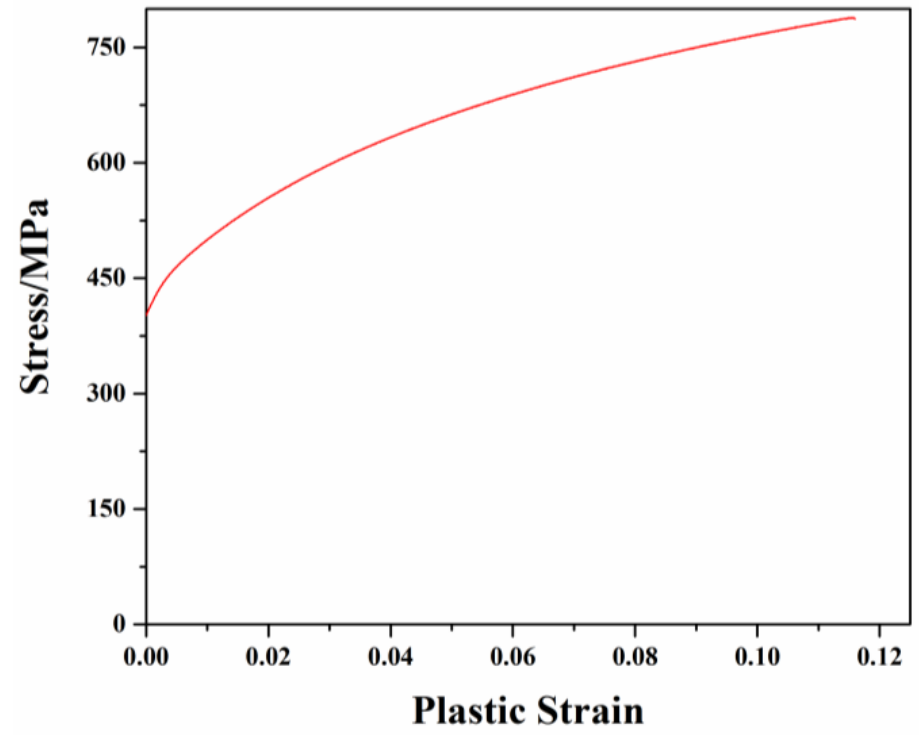
Figure 10. Tensile stress-plastic strain curve.